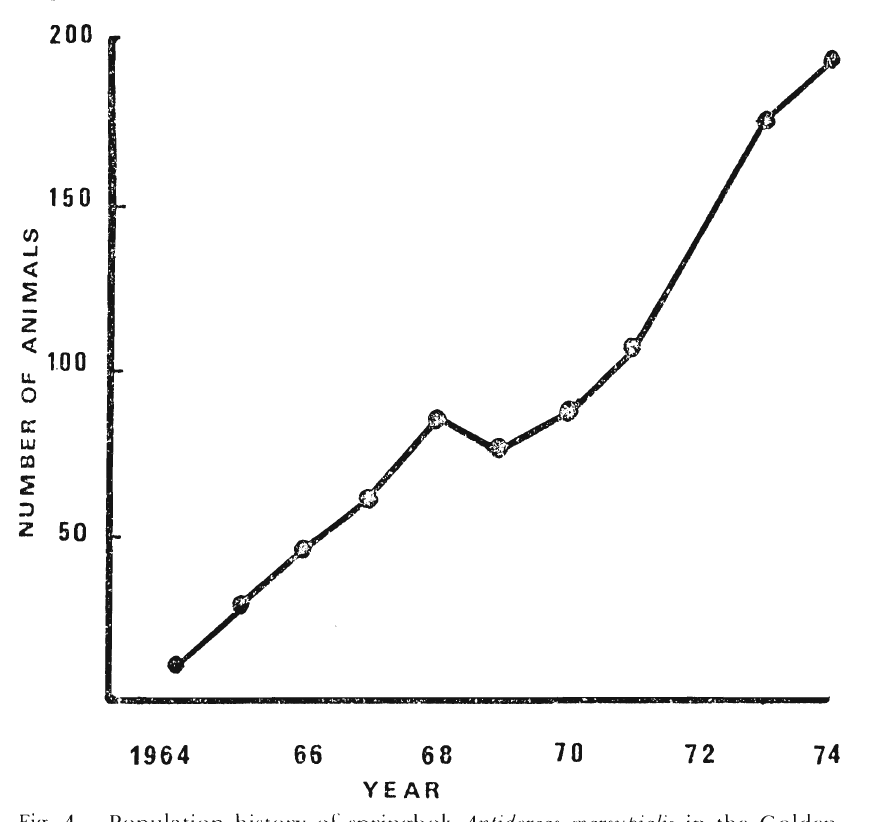
Fig. 4. Population history 01 springbok Antidorcas marsupialis in the Golden Gale Highland National Park, RSA. Golden Gate Highlands National Park